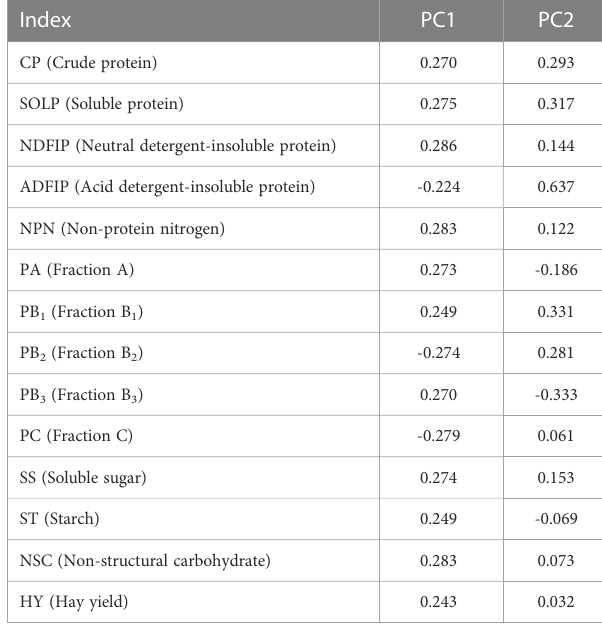
TABLE 1 Principal component score coef fi cient matrix.